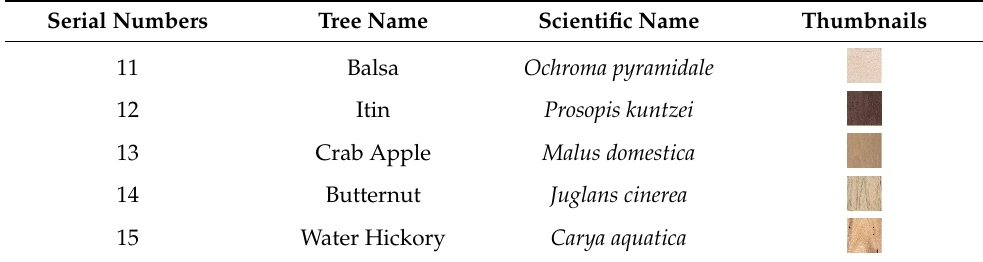
Figure 10. Subjective comparisons on the five wood grain images. From left to right: Gaussian im- ages, the results of Zhi et al. [27], Luo et al. [5], USM [24], the proposed algorithm before modifica- tion, and the proposed algorithm at the unified 1.5 coefficient. Table 4. Basic information of the five tree species.